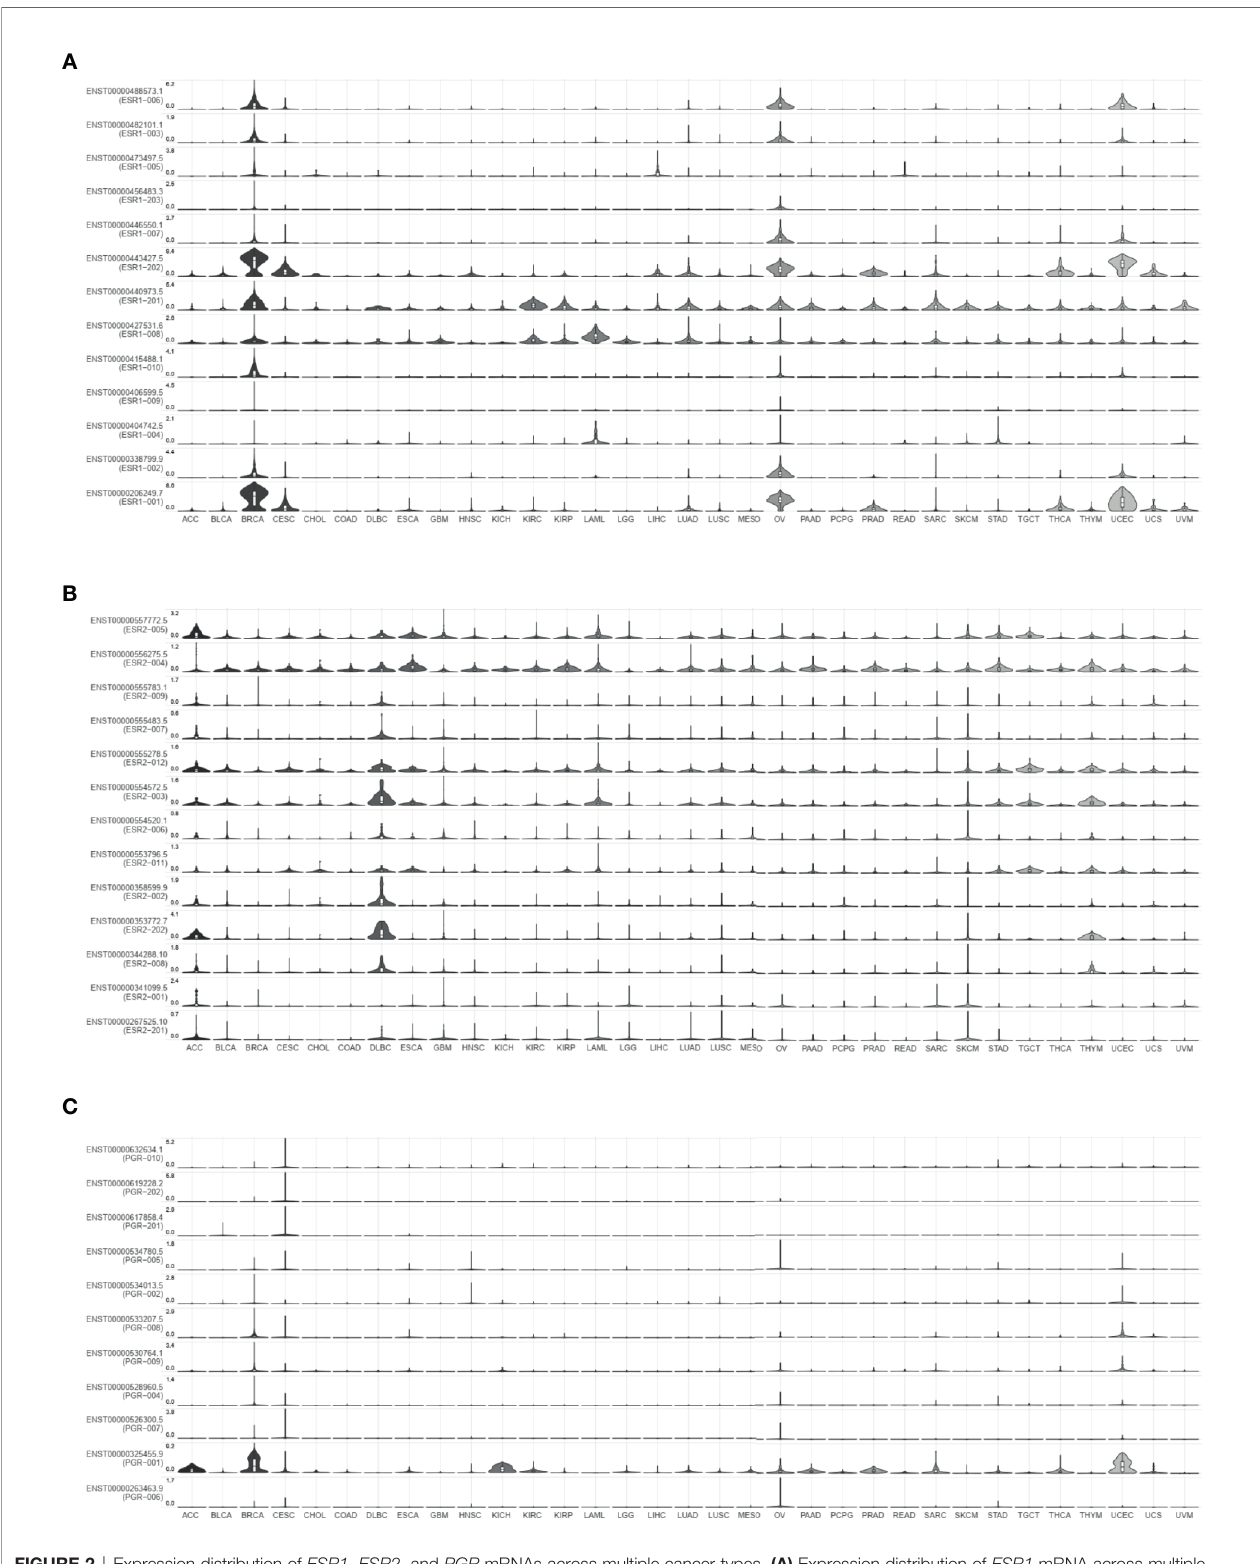
FIGURE 2 | Expression distribution of ESR1 , ESR2 , and PGR mRNAs across multiple cancer types. (A) Expression distribution of ESR1 mRNA across multiple cancer types. (B) Expression distribution of ESR2 mRNA across multiple cancer types. (C) Expression distribution of PGR mRNA across multiple cancer